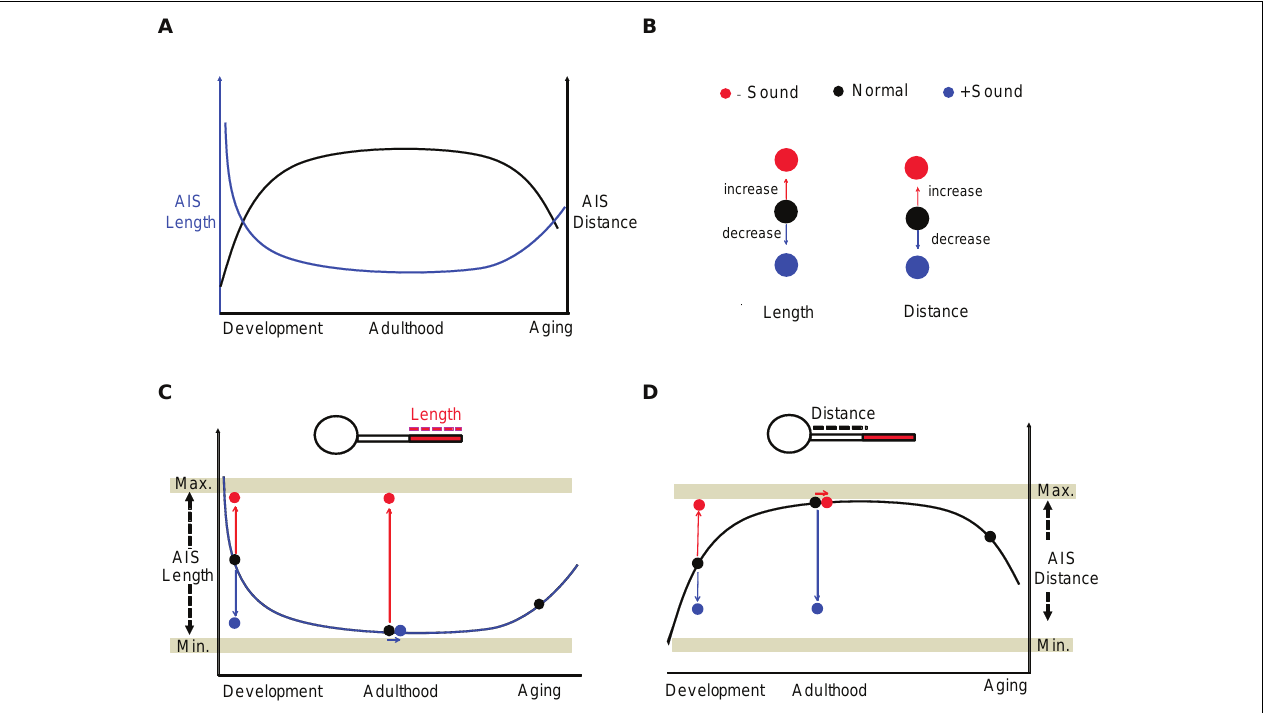
FIGURE 9 | Summary of the structural and spatial plasticity of the AIS in the auditory brainstem throughout life. (A) Diagram of AIS structural remodeling throughout the lifespan from neonatal development to aging. The plot of AIS distance (black) and length (blue) show a parabola and inverse parabola. (B) Effects of sound inputs on the structural plasticity of AIS; deaf mice or HL model ( − Sound, red) and sound stimulation ( + Sound, blue). (C,D) The impact of sound experiences on AIS structures throughout the lifespan. The structural plasticity occurs within the hypothetical minimum and maximum boundaries, which are indicated by Min. and Max. (gray horizontal